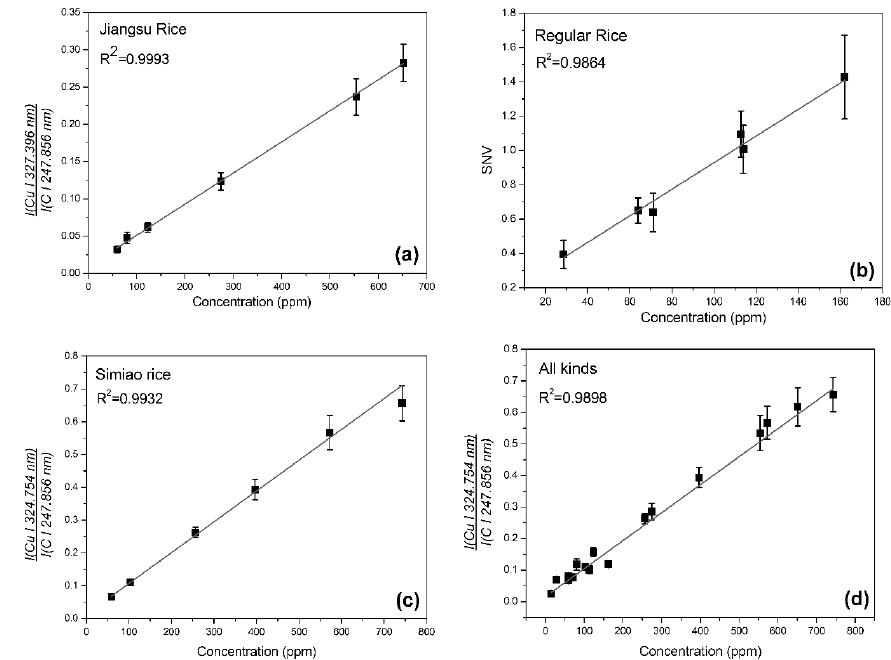
Figure 6. The best univariate calibration curves. ( a ) Jiangsu rice: I (Cu I 327.396 nm)/I (C I 247.856 nm); ( b ) regular rice: Cu at 327.396 with SNV processed; ( c ) Simiao rice: I (Cu I 324.754 nm)/I (C I 247.856 nm); and ( d ) the total samples: I (Cu I 324.754 nm)/I (C I 247.856 nm).